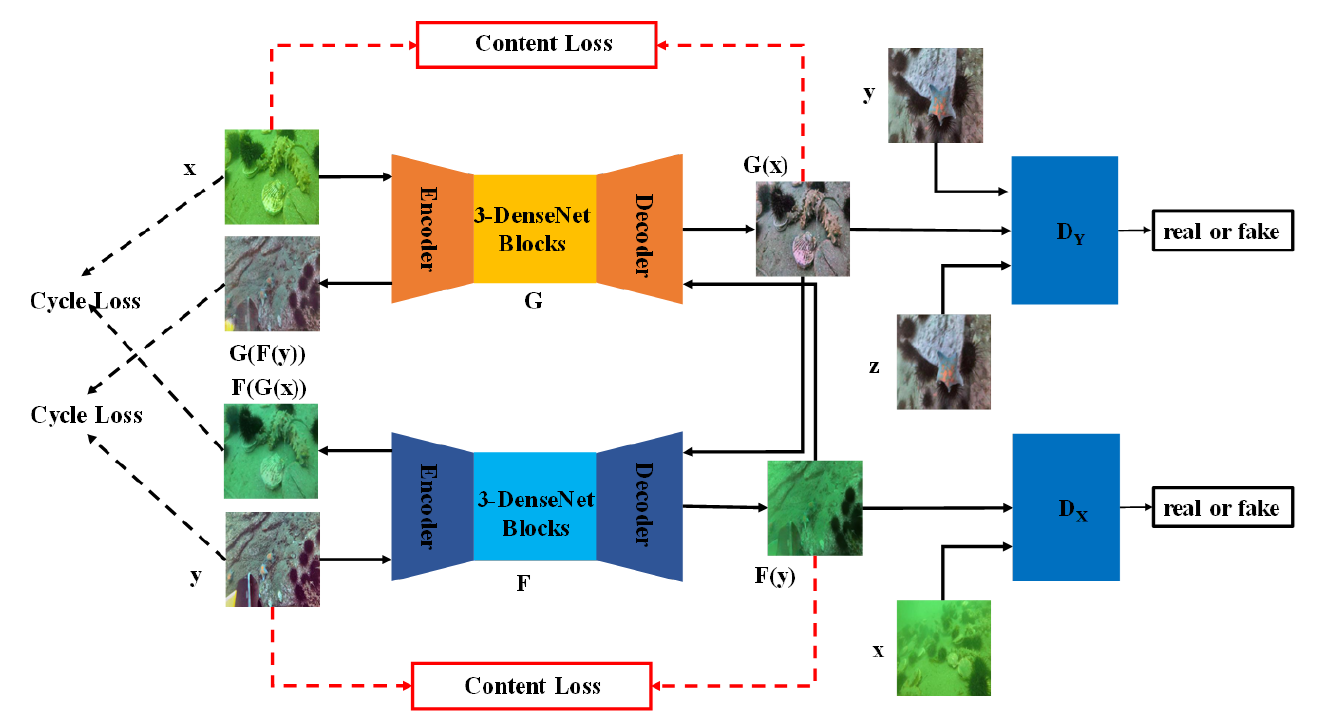
Figure 2. A brief illustration of UW-CycleGAN, which consists of two generators and two dis- criminators. The generator G (or F ) is a downsample–upsample framework with DenseNet blocks. The discriminator D Y (or D X ) comprises five full convolution